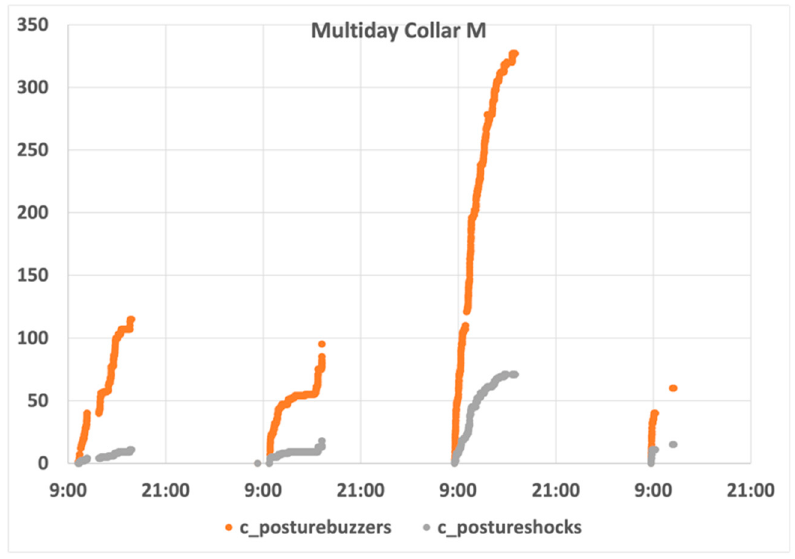
Figure 14. Collar M behaviour analysis.